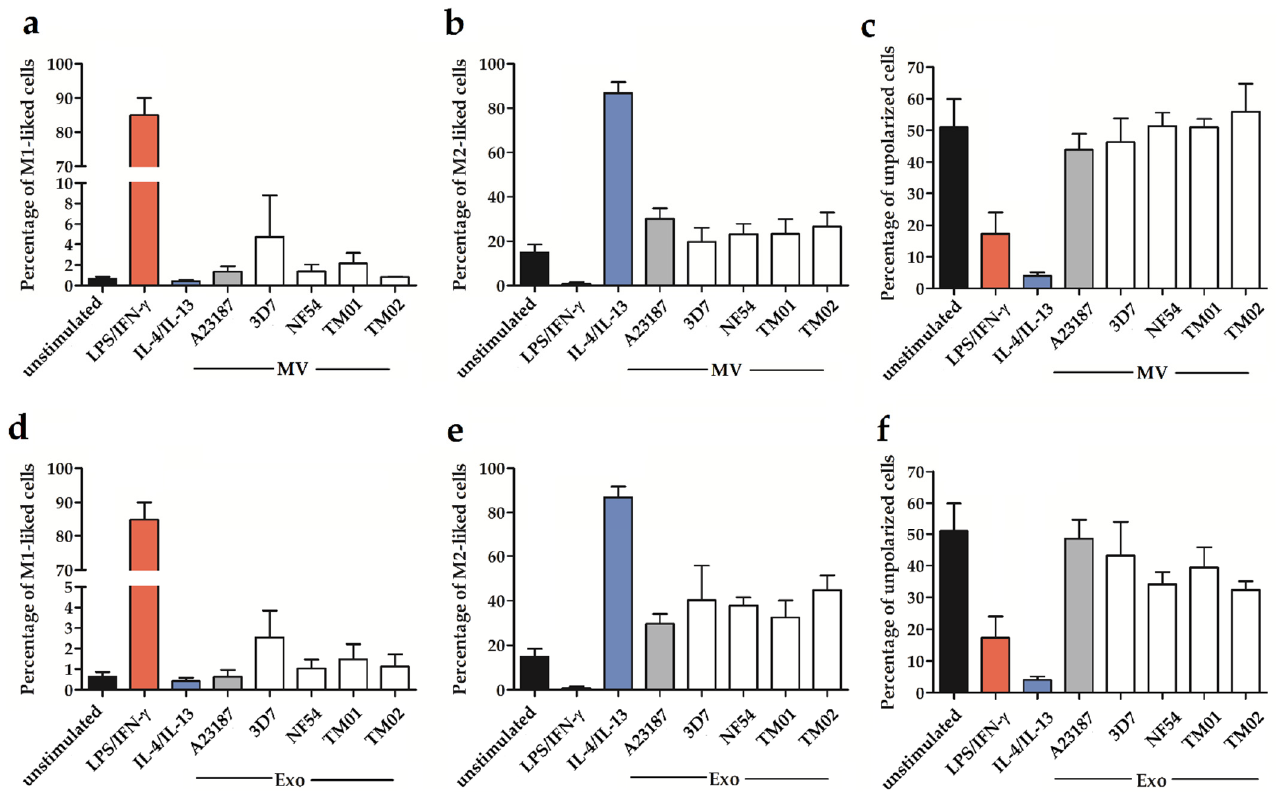
Figure 4. The monocyte polarization of the CD14 + CD16 − subpopulation after EV stimulation: MV stimulation (upper panel) and Exo stimulation (lower panel). The percentage of M1-like cells ( a , d ), M2-like cells ( b , e ), and unpolarized cells ( c , f ) among the CD14 + CD16 − subpopulation. LPS/IFN- γ and IL4/IL13 were stimulators for M1-like and M2-like cells. The data were shown as mean ± SEM from 4 independent experiments.